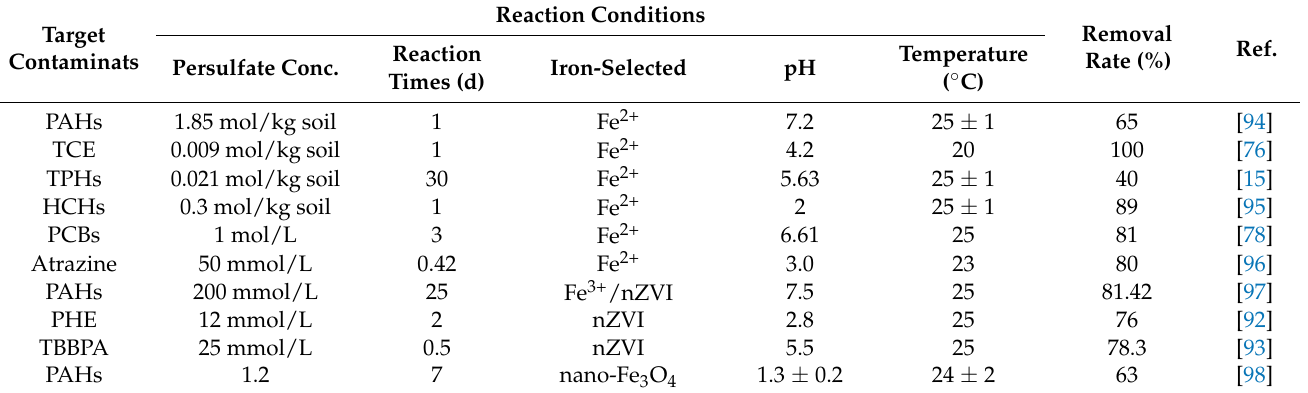
Table 3. Bench scale and laboratory studies with iron-activated